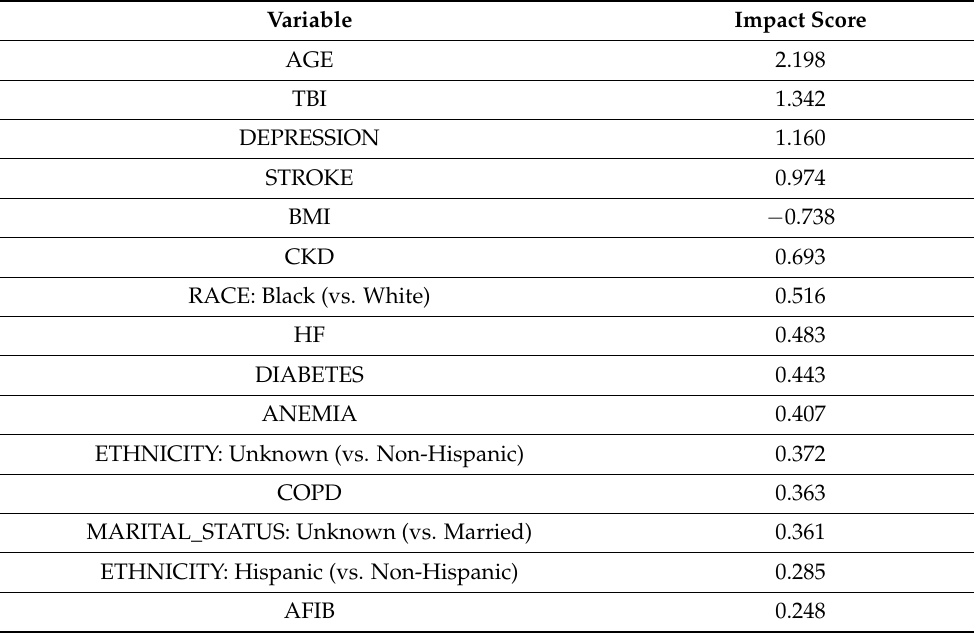
Table 2. Full list of variables and their impact scores on the real-world